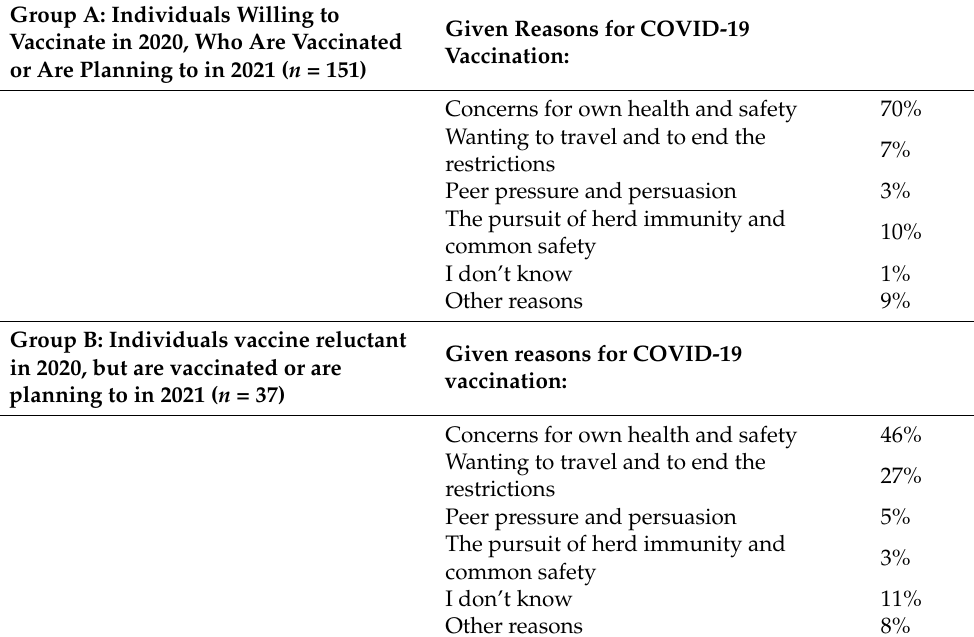
Table 2. Reasons for individual change of attitude towards COVID-19 vaccination among those